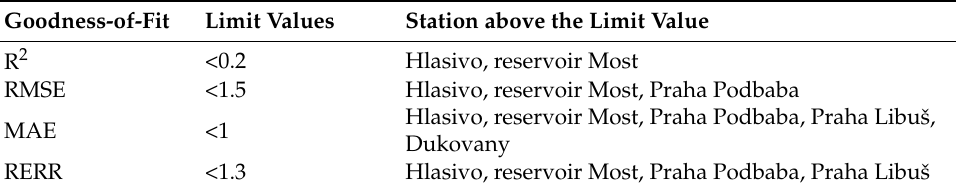
Table 1. Evaluation of evaporation stations based on GOF.